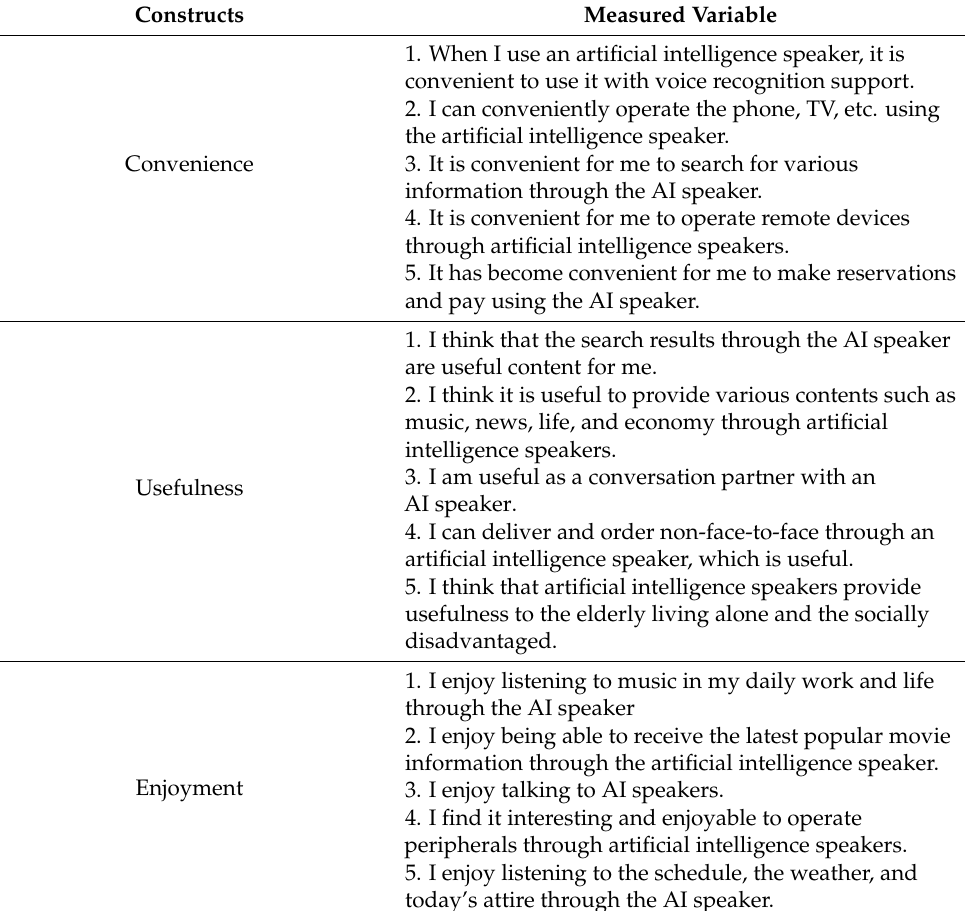
Table A1. Questionnaire